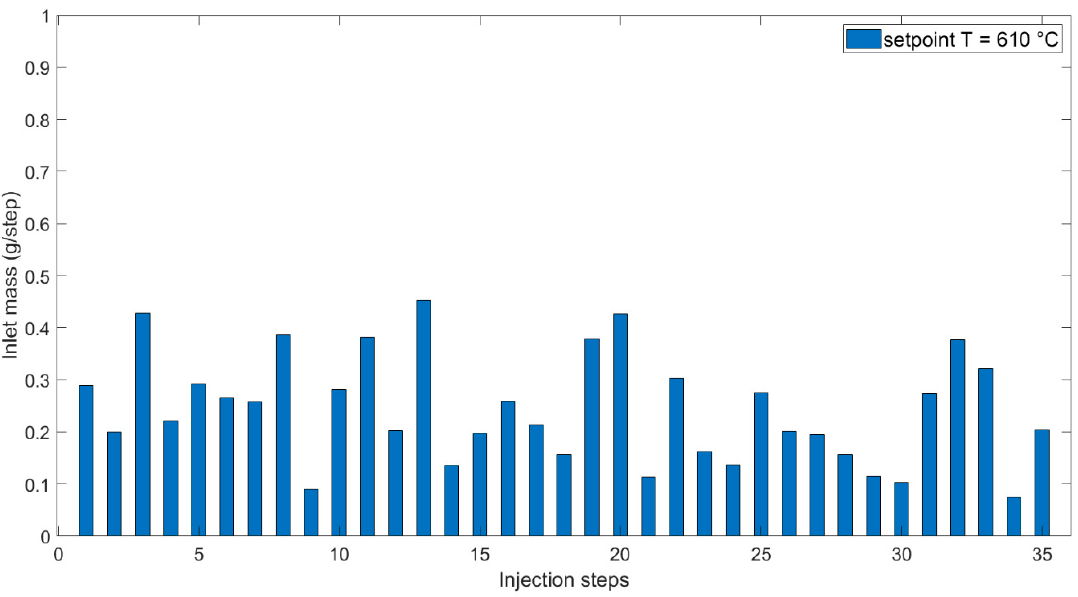
Figure 9. Inlet mass against injection steps at 510 °C setpoint temperature.